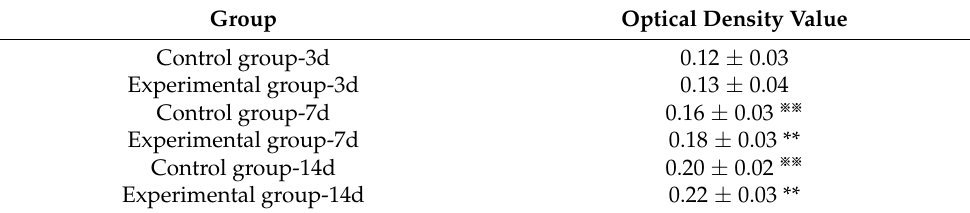
Figure 9. Masson staining results. Table 6. Optical density value statistics table.